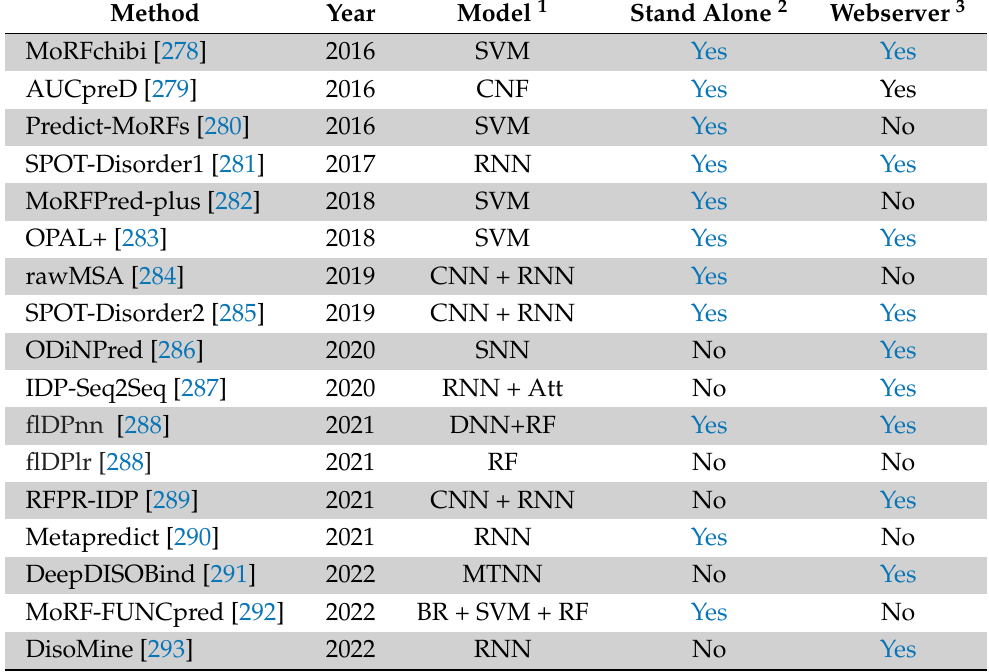
Table 4. Machine learning methods for IDP/IDPR prediction from 2016 to